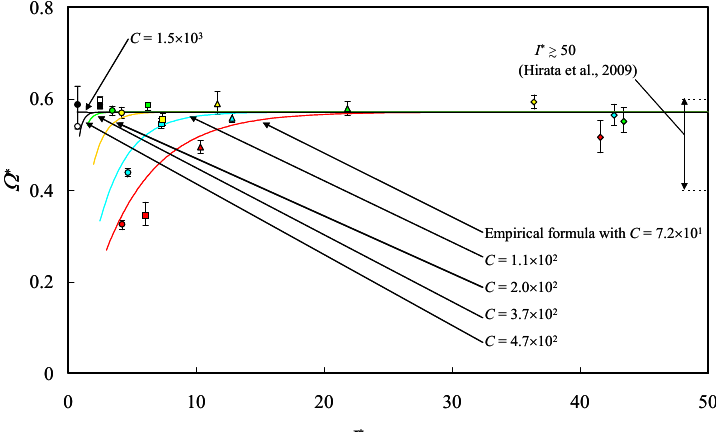
Fig. 6 Reduced rotating rate Ω * of versus inertia moment ratio I * , for λ = 0.3, AR = 10, C = 7.2 × 10 1 − 1.6 × 10 3 and I * = 0.75 − 43. Empirical formula is described as Eq.